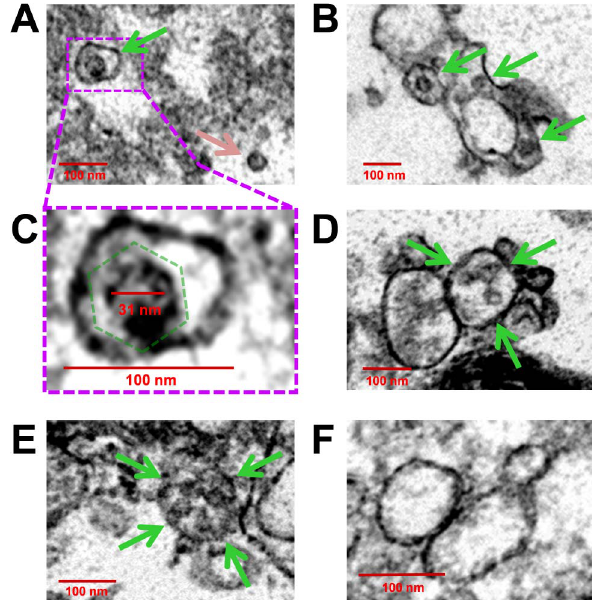
Figure 13. Virions were identified inside purified EMVs by transmission electron microscopy. EMVs were purified from mock- infected or infected differentiated C2C12 cells. Transmission electron microscopy was utilized to inspect EMVs for the presence of CVB3 virions. (A) Numerous virus-like particles within microvesicles (green arrow), although free virions was also observed (pink arrow). (B) EMVs harboring virus-like particles (green arrows) were of varying size. (C) Higher digital magnification (dashed purple box) of a virus-like particle revealed an icosahedral shape structure (dashed green polygon) slightly larger than 31 nm in diameter enclosed within a membrane structure. (D) , (E) Larger microvesicles also contained multiple virions (green arrows). (F) In contrast, microvesicles isolated from mock-infected C2C12 cells were identified by EM without virus-like particles.